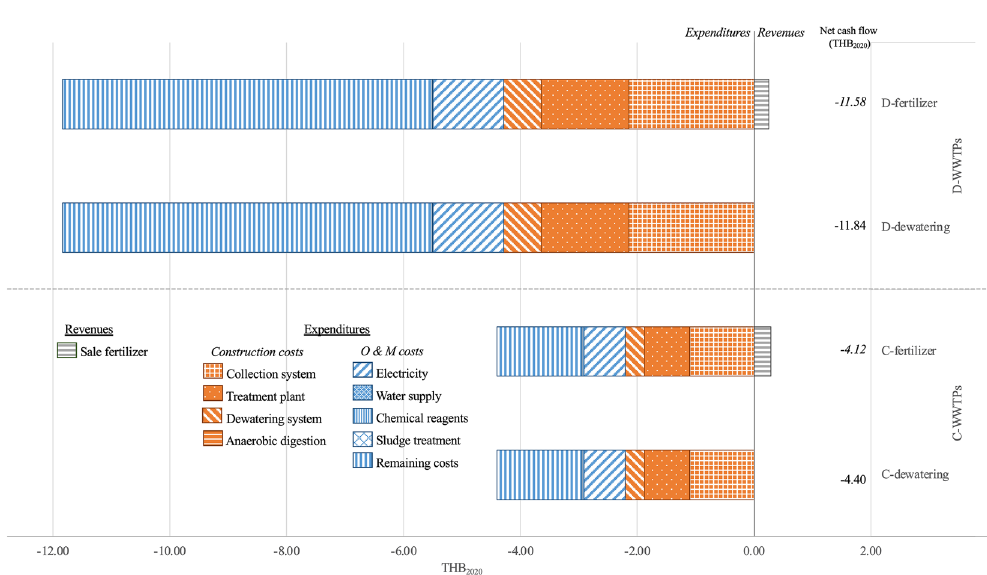
Figure 4. Cash inflow and cash outflow of four sludge treatment scenarios in Thai baht 2020